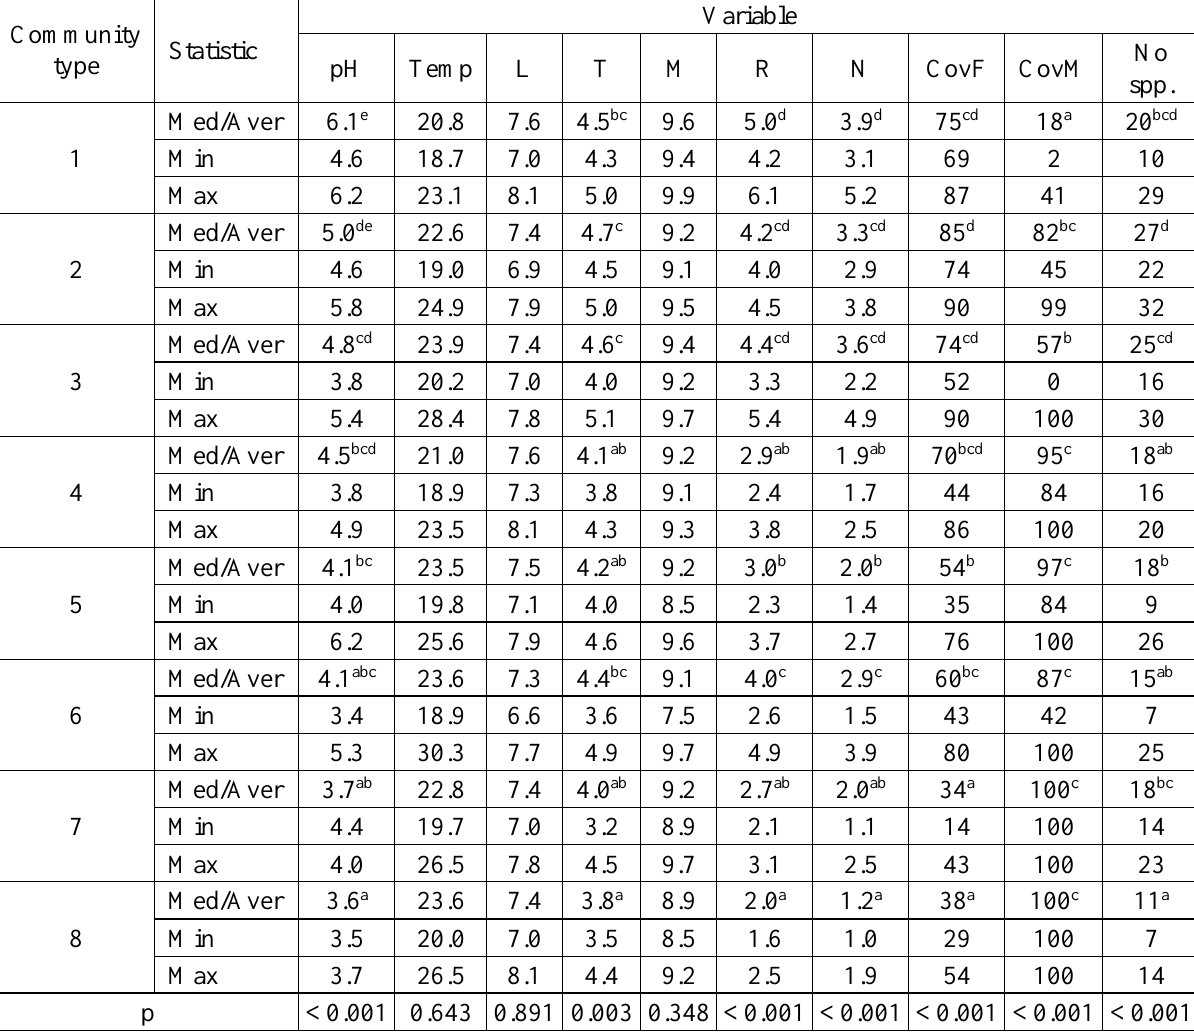
Table 8. Median values of pH, average values of other environmental variables and community characteristics by community type. No spp. = average number of species, other notations as in Table